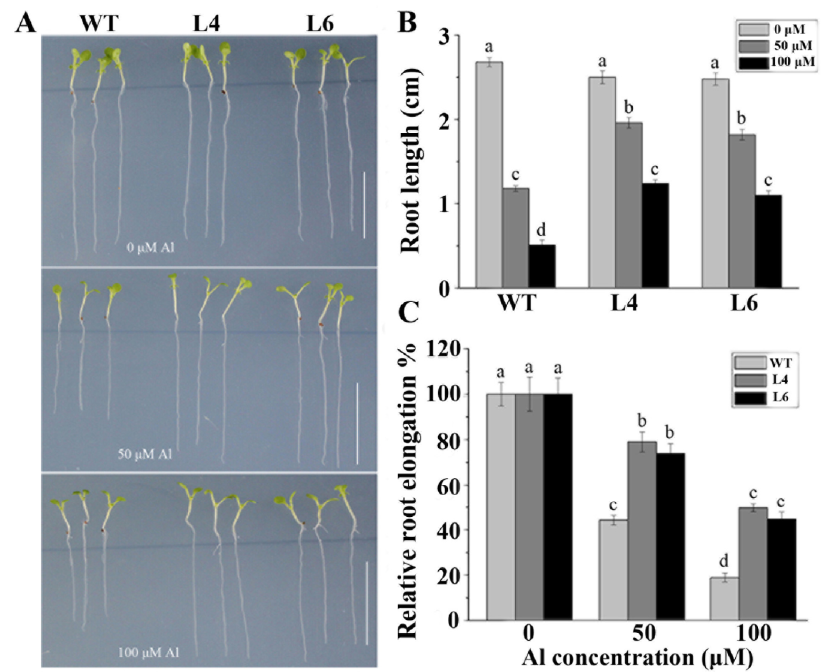
Figure 3. Subcellular localization of ZmALDH in tobacco leaves.